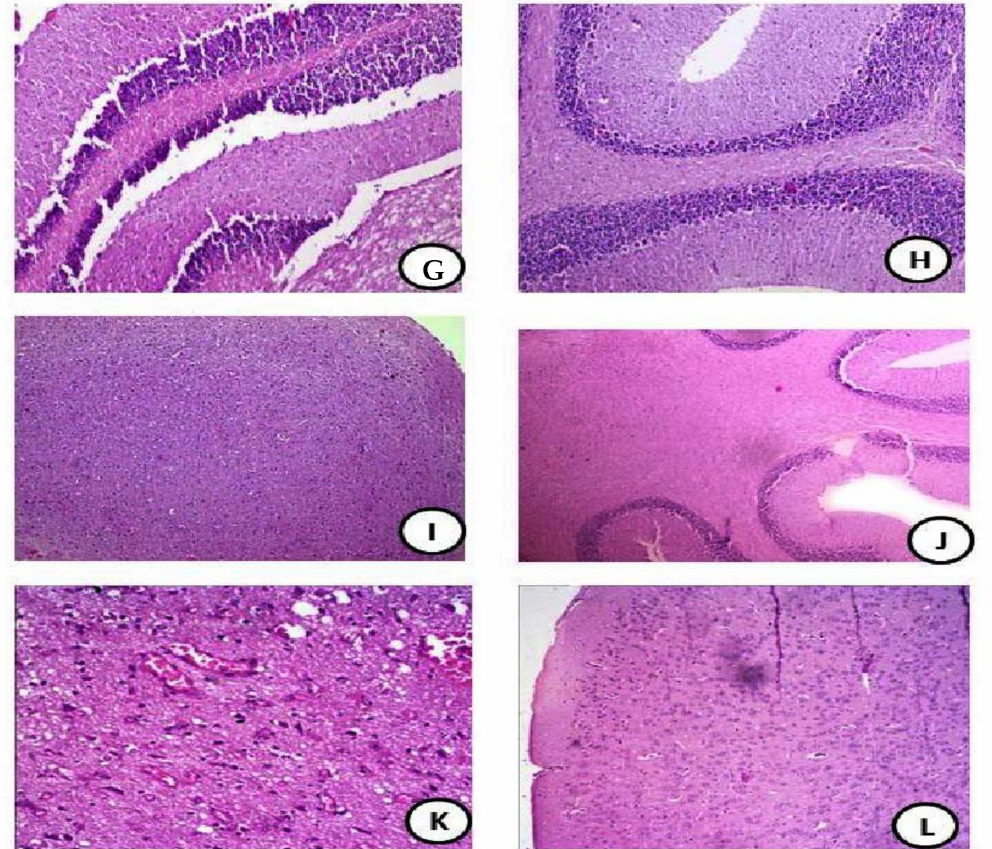
Figure 4. Cross sections of mice brain tissues from the treated groups showing structure alterations. H & E stain × 400: ( A ) Control group showed normal cerebral cortex with normal pyramidal cells (H&EX100); ( B ) DG treated group showed disorganized pyramidal cells (red head arrow) with small dark nuclei with granular cells showing apoptotic nuclei (H&EX400); ( C ) CH-NPs (high dose) showed normal cerebral cortex with normal pyramidal cells with normal sized nuclei (H&EX400); ( D ) CH- NPs (low dose) group showed normal cerebral cortex with normal glial cells with normal sized nuclei (H&EX400); ( E ) RV group showed normal cerebral cortex with normal pyramidal cells with normal sized nuclei (H&EX400); ( F ) Q group showed normal cerebral cortex with normal pyramidal cells with normal sized nuclei (H&EX400); ( G ) CH-NPs (low dose) + resveratrol group showed normal cerebral cortex with normal pyramidal cells with normal sized nuclei (black arrow) (H&EX400); ( H ) CH-NPs (High dose) + RV group showed normal cerebral cortex with normal pyramidal cells with normal sized nuclei (H&EX100); ( I ) CH-NPs (low dose) + Q group showed normal cerebral cortex with normal pyramidal cells with normal sized nuclei (black arrow) (H&EX100); ( J ) CH-NPs (high dose) + Q group showed normal cerebral cortex with normal pyramidal cells with normal sized nuclei (black arrow) (H&EX100); ( K ) DG + CH-NPs (Low dose) + RV + Q showed mild congested blood vessels (red arrow) and neural cells showing small dark stained nuclei (H&EX400); ( L ) DG + CH-NPs (High dose) + RV + Q showed the brain with highly ameliorative effect than DG group